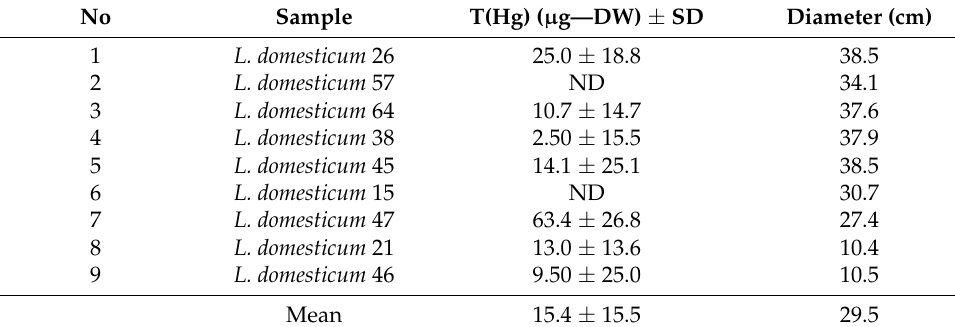
Table 4. Total weight of Hg (THg) in the bark and diameter of Lansium domesticum .